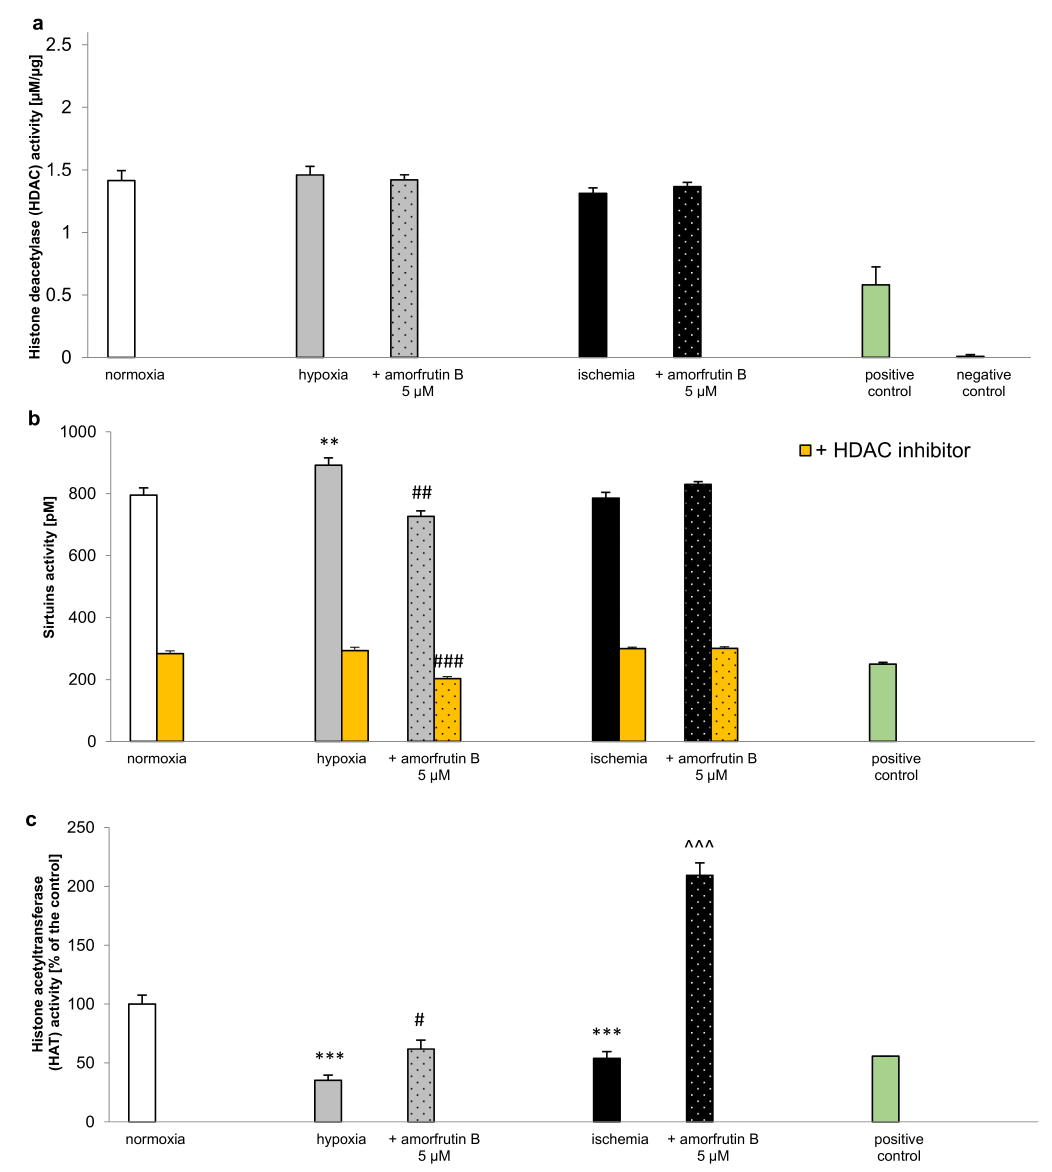
Figure 10. Hypoxic or ischemic conditions and exposure to amorfrutin B (5 µ M) post-treatment did not contribute to changes in histone deacetylase (HDAC) activity ( a ) but altered sirtuins and nonsirtuins action ( b ) and histone acetyltransferase (HAT) activity ( c ). A positive control contained HeLa cell lysate for HDAC, an undefined sample for sirtuins, and a HeLa nuclear extract for HAT. Negative control had no cells, and an HDAC inhibitor (trichostatin A) was added to inhibit nonsirituin activities in the samples. The results are presented as the mean ± SEM (HDAC and sirtuins activity) or as a percentage of the control ± SEM (HAT activity). There were 3 independent experiments, consisting of 5–6 replicates per group. ** p < 0.01, and *** p < 0.001 compared to the control group, # p < 0.05, ## p < 0.01, ### p < 0.001 compared to the cultures exposed to hypoxia, ˆˆˆ p < 0.001 compared to the cultures exposed to